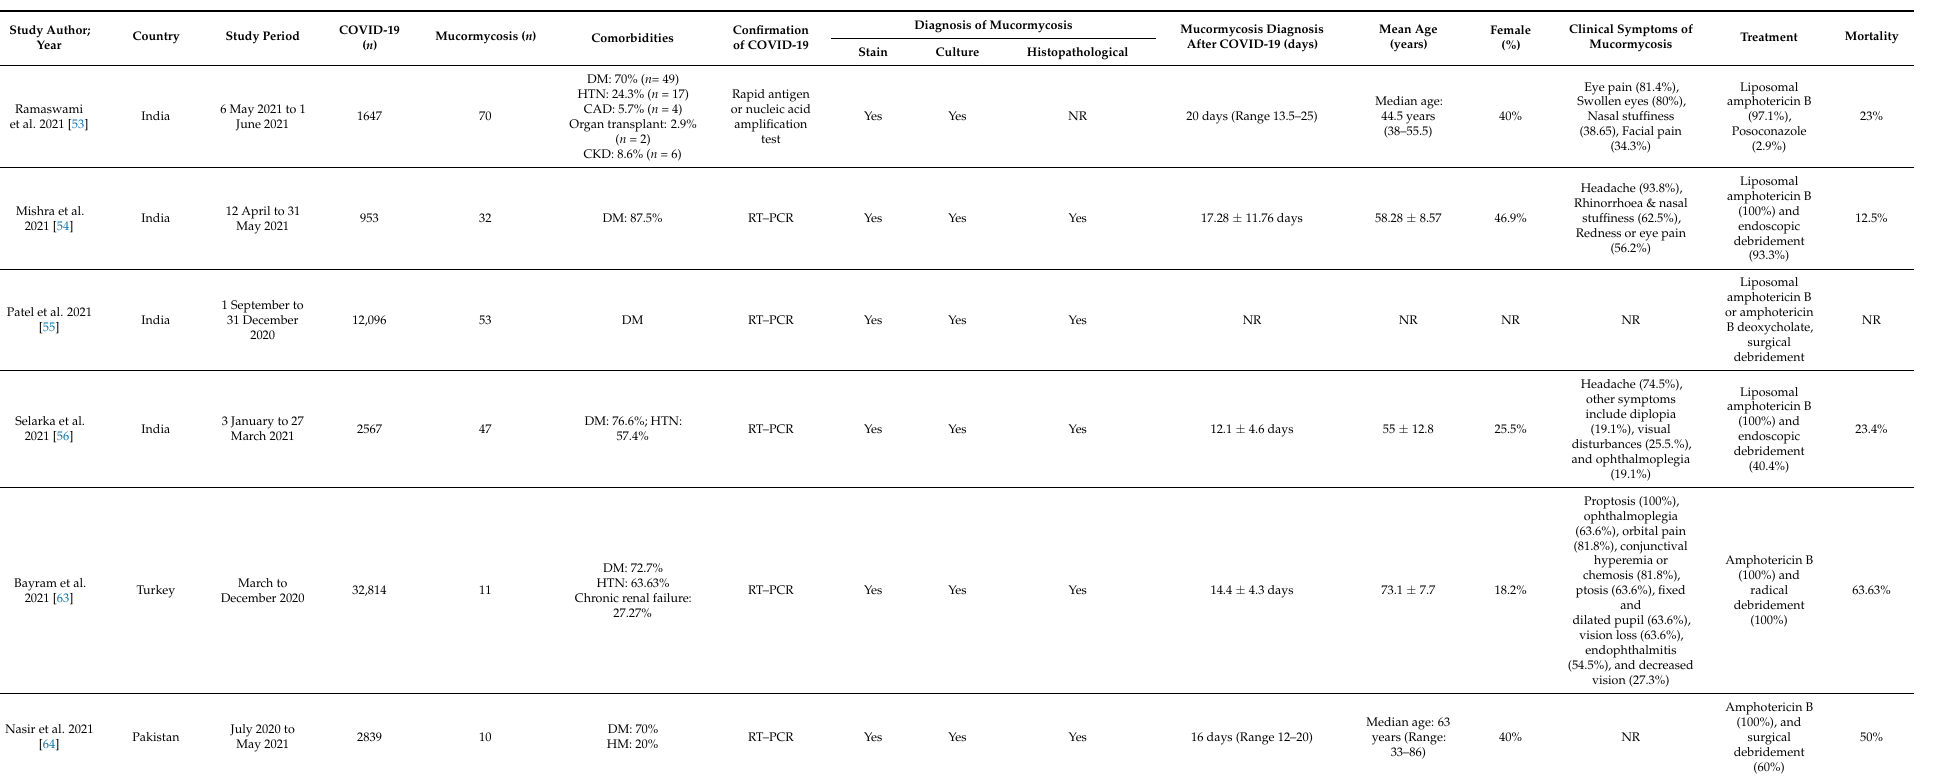
Table 1. Included Studies’ Characterstics. Global Prevalence of COVID-19-associated Mucormycosis (CAM), as of August